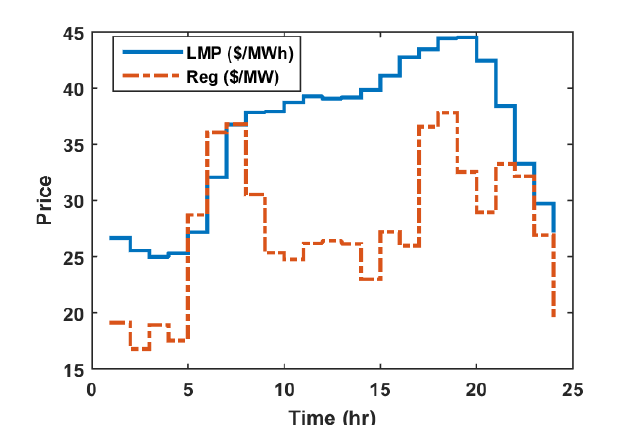
Figure 3. PJM annual average prices in